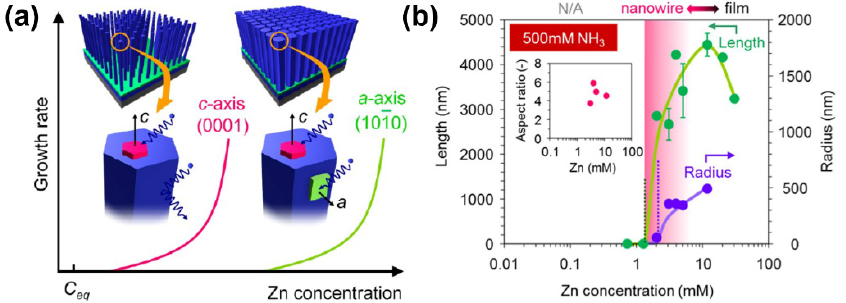
Figure 6. Face-selective control of hydrothermal zinc oxide nanowire: ( a ) schematic of a concentration dependence on the crystal growth of hydrothermal ZnO nanowires as a crystal-plane dependence on a critical nucleation concentration. Reprinted from reference [111] with permission from the American Chemical Society; ( b ) Zn concentration dependence of ZnO nanowire morphology with HMTA 15 mM with ammonia addition 500 mM. The Zn concentration range, where a nanowire can be grown, is highlighted by a red color. Reprinted from reference [161] with permission from the Nature Publishing Group.